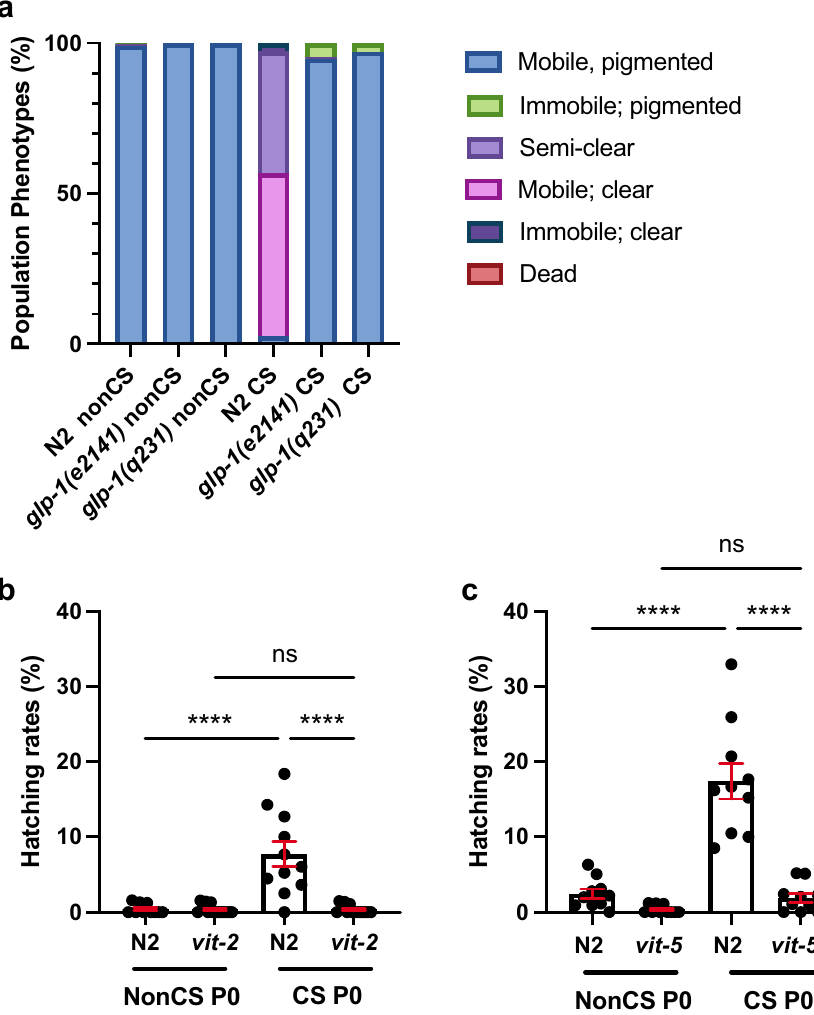
Figure 7. Cold shock response is a form of terminal investment. ( a ) glp-1(e2141) and glp-1(q231) were grown at the restrictive temperature (25 °C) to induce sterility and then habituated at 20 °C for 4 h. Worms were then cold shocked or mock shocked (nonCS) and recovered at 20 °C for 24 h and phenotypes were scored (n ≥ 197 worms for all conditions; Chi-Squared Test for Homogeneity, P < 0.0001 for N2 CS vs. e2141 CS or q231 CS). ( b ) Young adult hermaphrodite N2 and vit-2(ok3211) (P0) were cold shocked or mock shocked (nonCS) for 4 h and recovered for 16 h. Embryos from P0 treatments were collected from 16 to 18 h and cold shocked for 24 h. Embryos were allowed to recover 24 h at 20 °C and then the number of hatched embryos was quantified. Data points represent rates as percent hatched for a plate containing 50–100 embryos (n ≥ 10 plates per condition; 2-way ANOVA (F(3,32) = 20.87, P < 0.0001) with Tukey multiple comparison test (**** P < 0.0001). Bars are mean ± s.e.m. ( c ) Performed as in b with N2 and vit-5 (ok3239) worms (n = 10 plates per condition; 2-way ANOVA (F(3,27) = 35.28, P < 0.0001) and Tukey multiple comparison test (**** P <